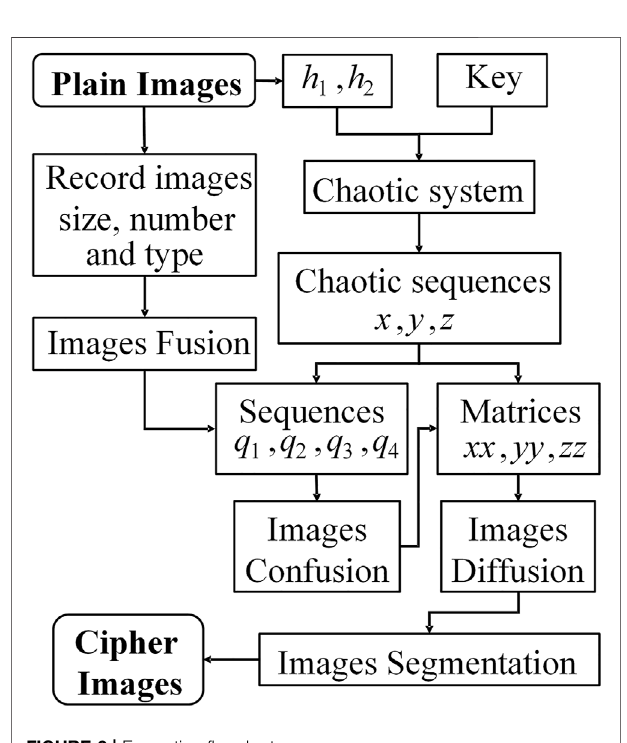
FIGURE 2 | Encryption fl